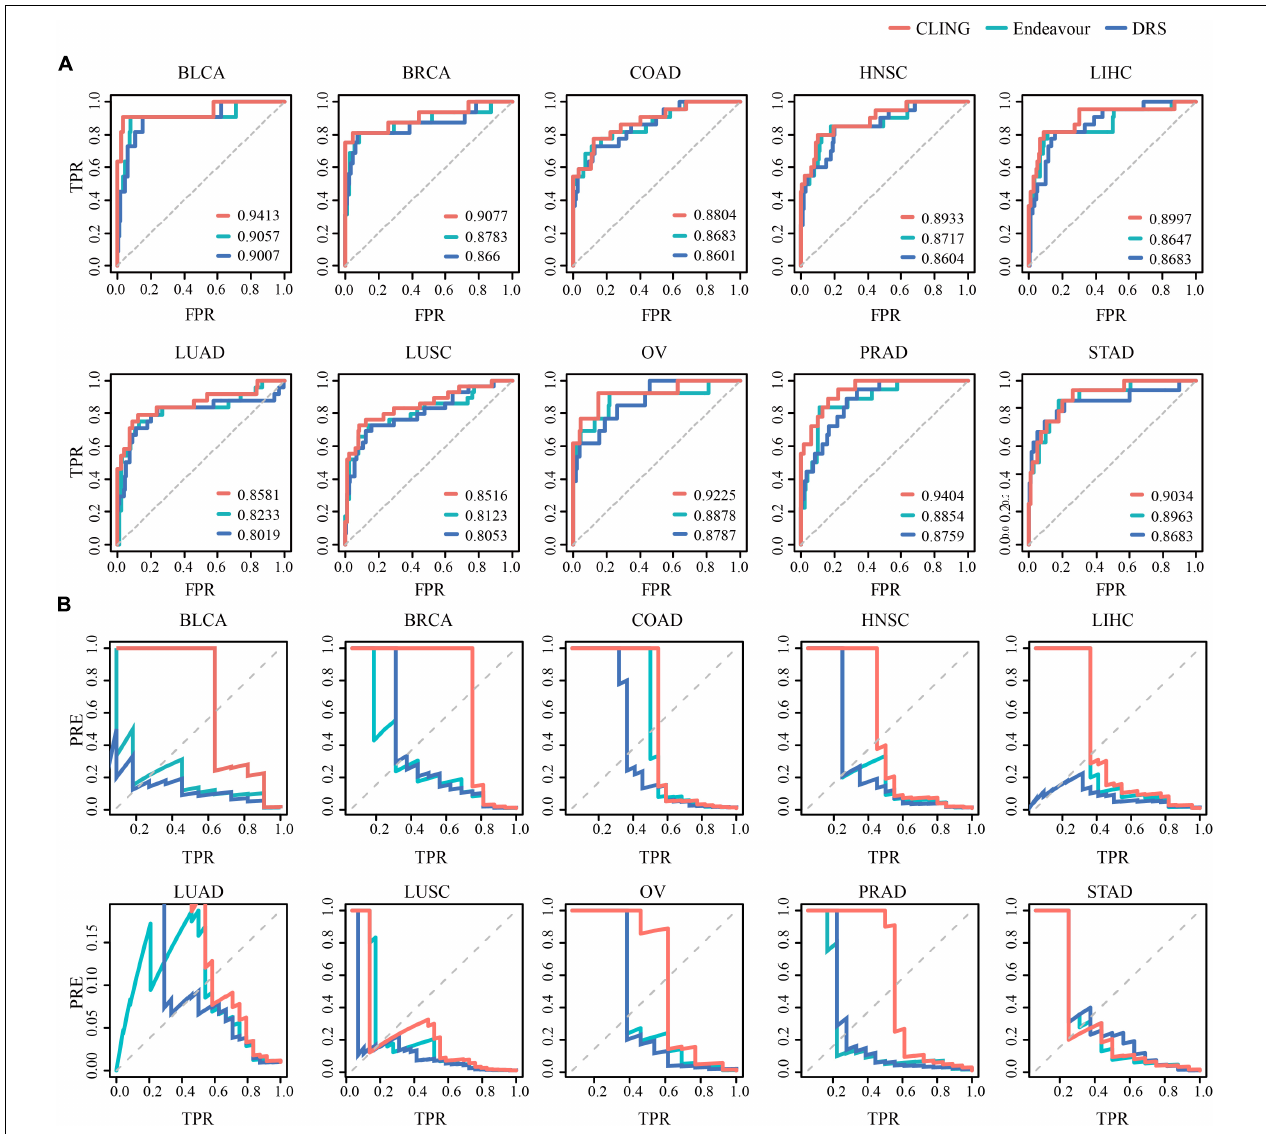
FIGURE 4 | Prediction power of known cancer lncRNAs performed for CLING, Endeavor and DRS. (A) ROC curves indicate that CLING performed better than other methods. (B) Curves showing prediction precision (PRE) vs. recall (or TPR) indicate that CLING outperformed other